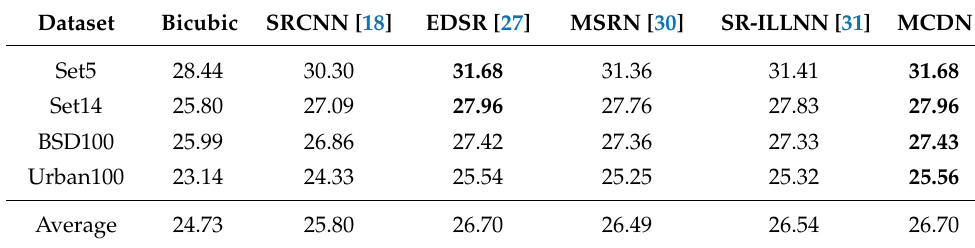
Table 4. Average PSNR (dB) on the test datasets. The best results of dataset are shown in bold.